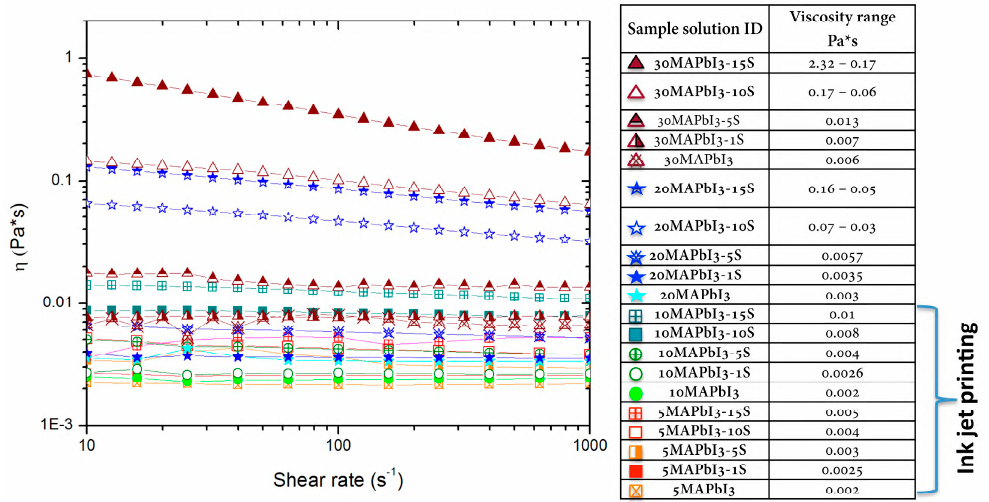
Figure 1. Rheological characterization of the perovskite-starch-based solutions investigated by varying the precursors and starch concentrations.